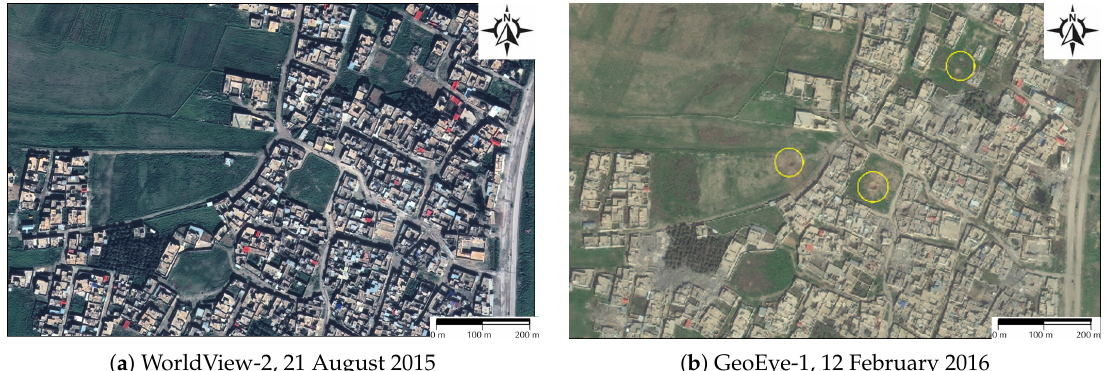
Figure 9. Weapon impact damage type, where impact craters can be identified in the imagery (highlighted in yellow) c (cid:13)